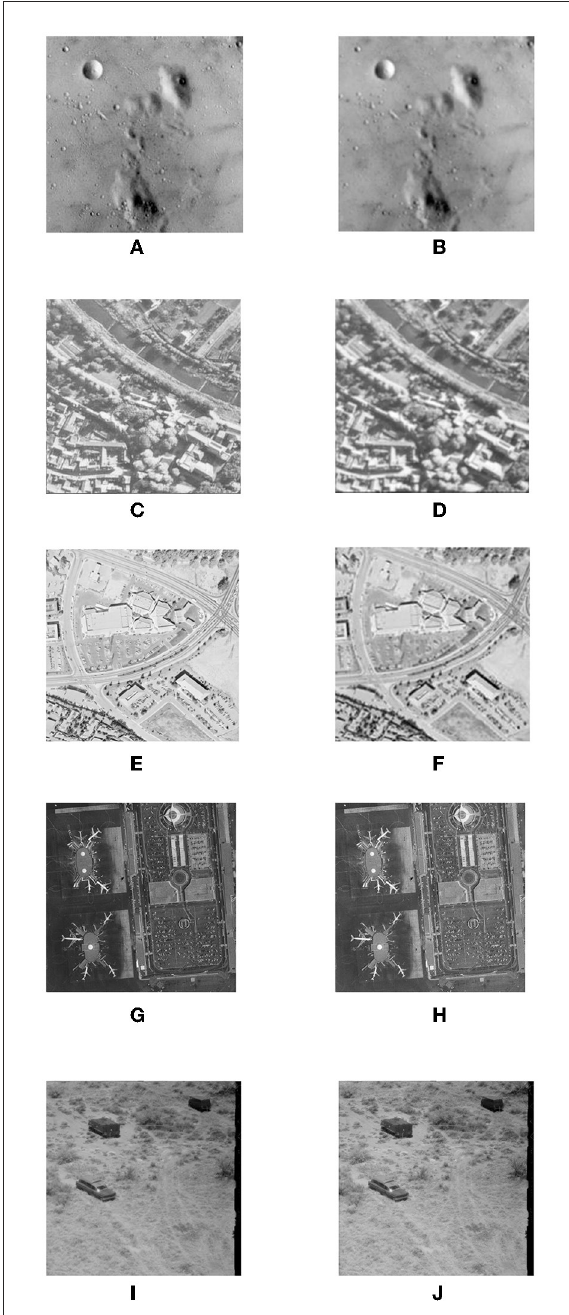
FIGURE7 Watermarked images using GA-based mixing matrix coefficient optimization and its objective evaluation of imperceptibility for different images. (A) Original Test1. (B) Watermarked Image (PSNR = 51.2 and SSIM = 0.98). (C) Original Test2. (D) Watermarked Image (PSNR = 53.9 and SSIM = 0.95). (E) Original Test3. (F) Watermarked Image (PSNR = 53.9 and SSIM = 0.96). (G) Original Test4. (H) Watermarked Image (PSNR = 50.6 and SSIM = 0.96). (I) Original Test5. (J) Watermarked Image (PSNR = 53.8 and SSIM = 0.96).